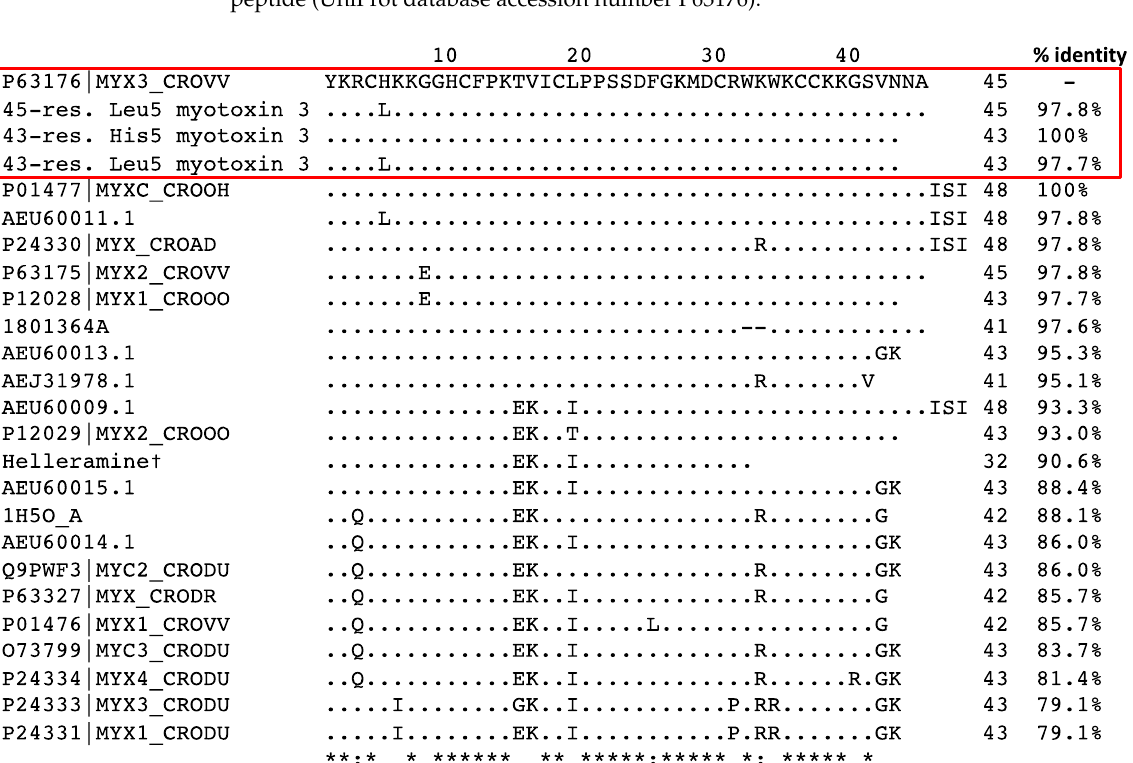
Figure 4. The a mino acid sequence of myotoxin-3 and its isoforms. The amino acid sequence of peptides from peak 1 (blue) and peak 2 (black) with calculated (ProtParam tool) and experimental masses. Residues in position 5 residues are highlighted in bold. Myotoxin-3 corresponds to the first peptide (UniProt database accession number P63176).